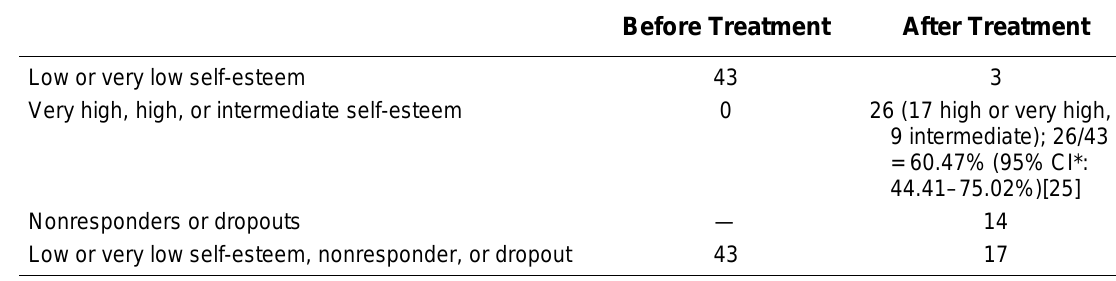
Clinical Holistic Medicine Cure of Patients from Self-Assessed Self-Esteem Before Treatment After